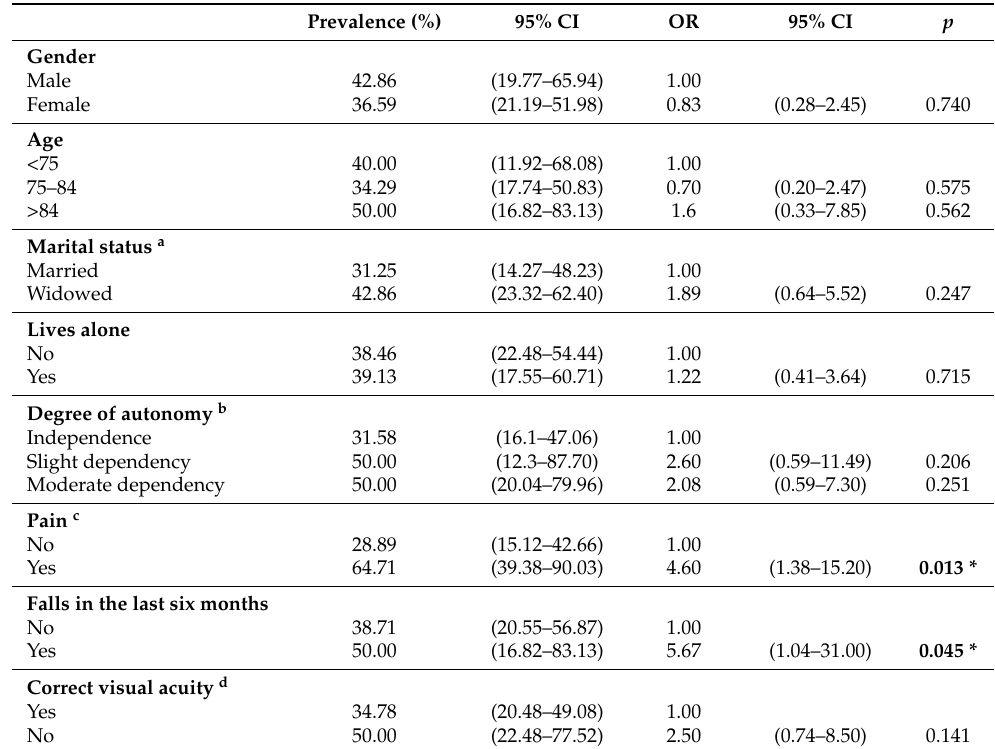
Table 3. The influence of possible determinants on the prevalence of fear of